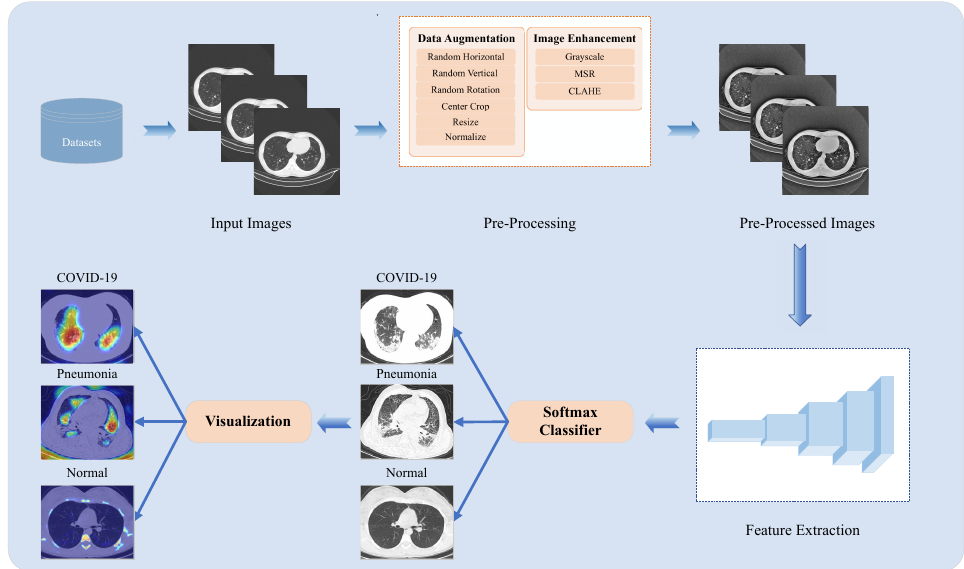
Figure 2. Workflow of the proposed COVID-19 classification